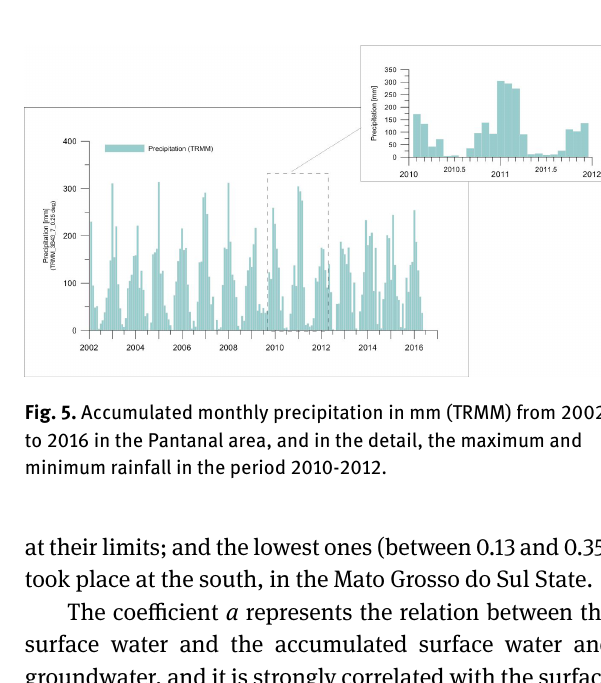
at their limits; and the lowest ones (between 0.13 and 0.35) took place at the south, in the Mato Grosso do Sul State. The coefficient a represents the relation between the surface water and the accumulated surface water and groundwater, and it is strongly correlated with the surface water dynamics. The theoretical limit of a is equal to 1, which can occur in the ocean, and high a values means low GRACE sensitivity to the surface water mass variations (Matos et al. 2012). The results of the a coefficients of